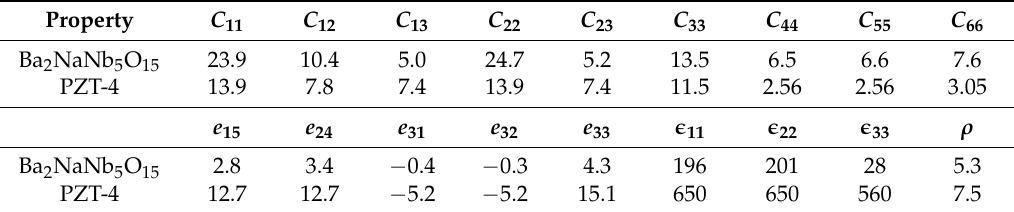
Table 1. Material parameters of two piezoelectric